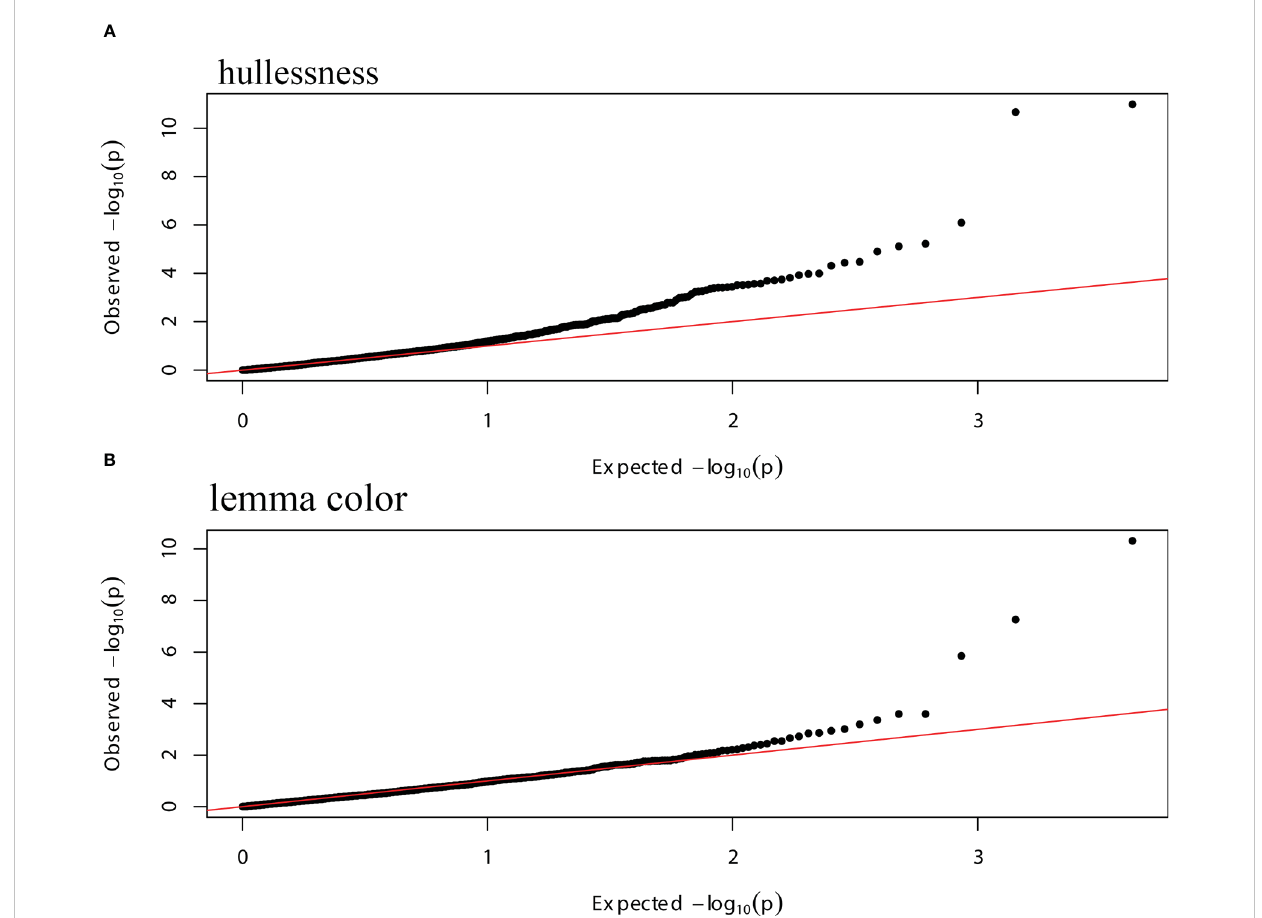
FIGURE 6 Quantile-quantile (Q-Q) plots of the GWAS data of hullessness and lemma color using a mixed model, with the PCA matrix and kinship information as covariates. (A) Hullessness; (B) lemma